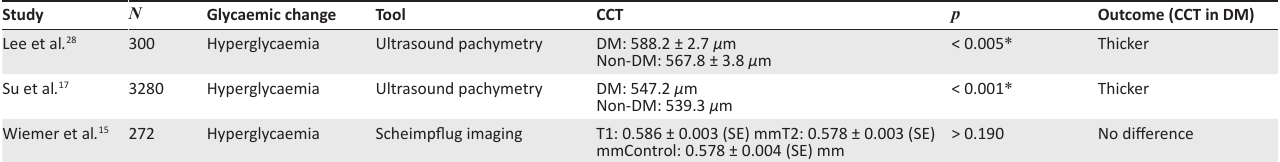
TABLE 3: Effect of glycaemic changes on corneal thickness in people with diabetes mellitus. Study N Glycaemic change